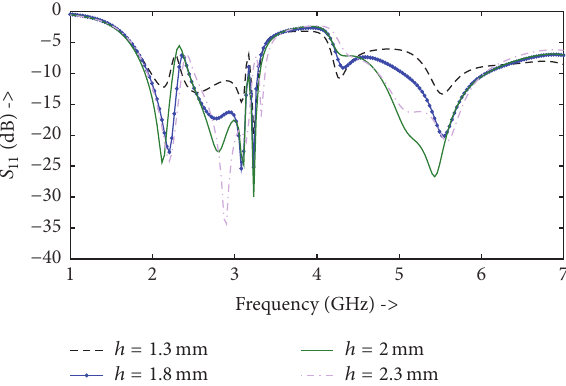
Figure 9: Reflection coefficient of different location of shorting pin.